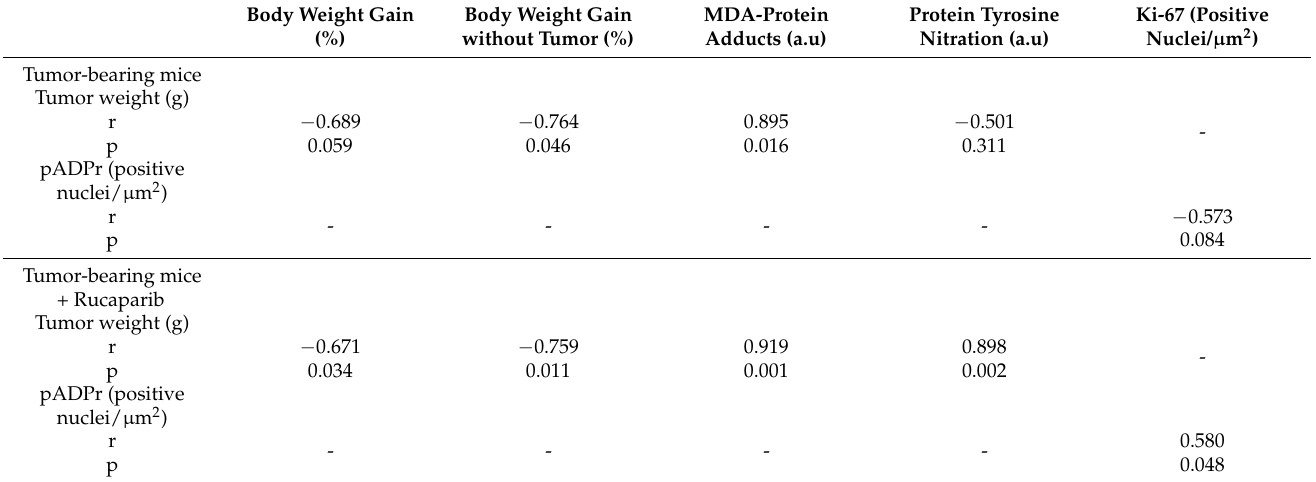
Table 2. Associations of the study variables analyzed in the tumors of the experimental